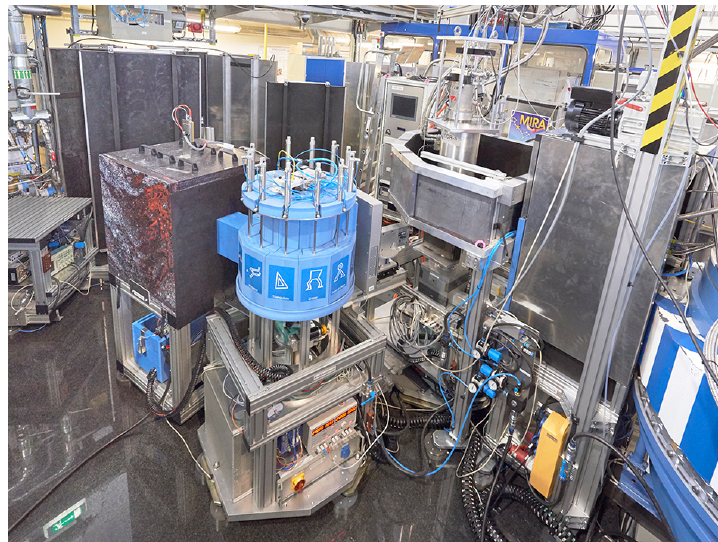
Figure 1: Instrument MIRA-2 in three axes mode (Copyright by W. Schürmann, TUM).